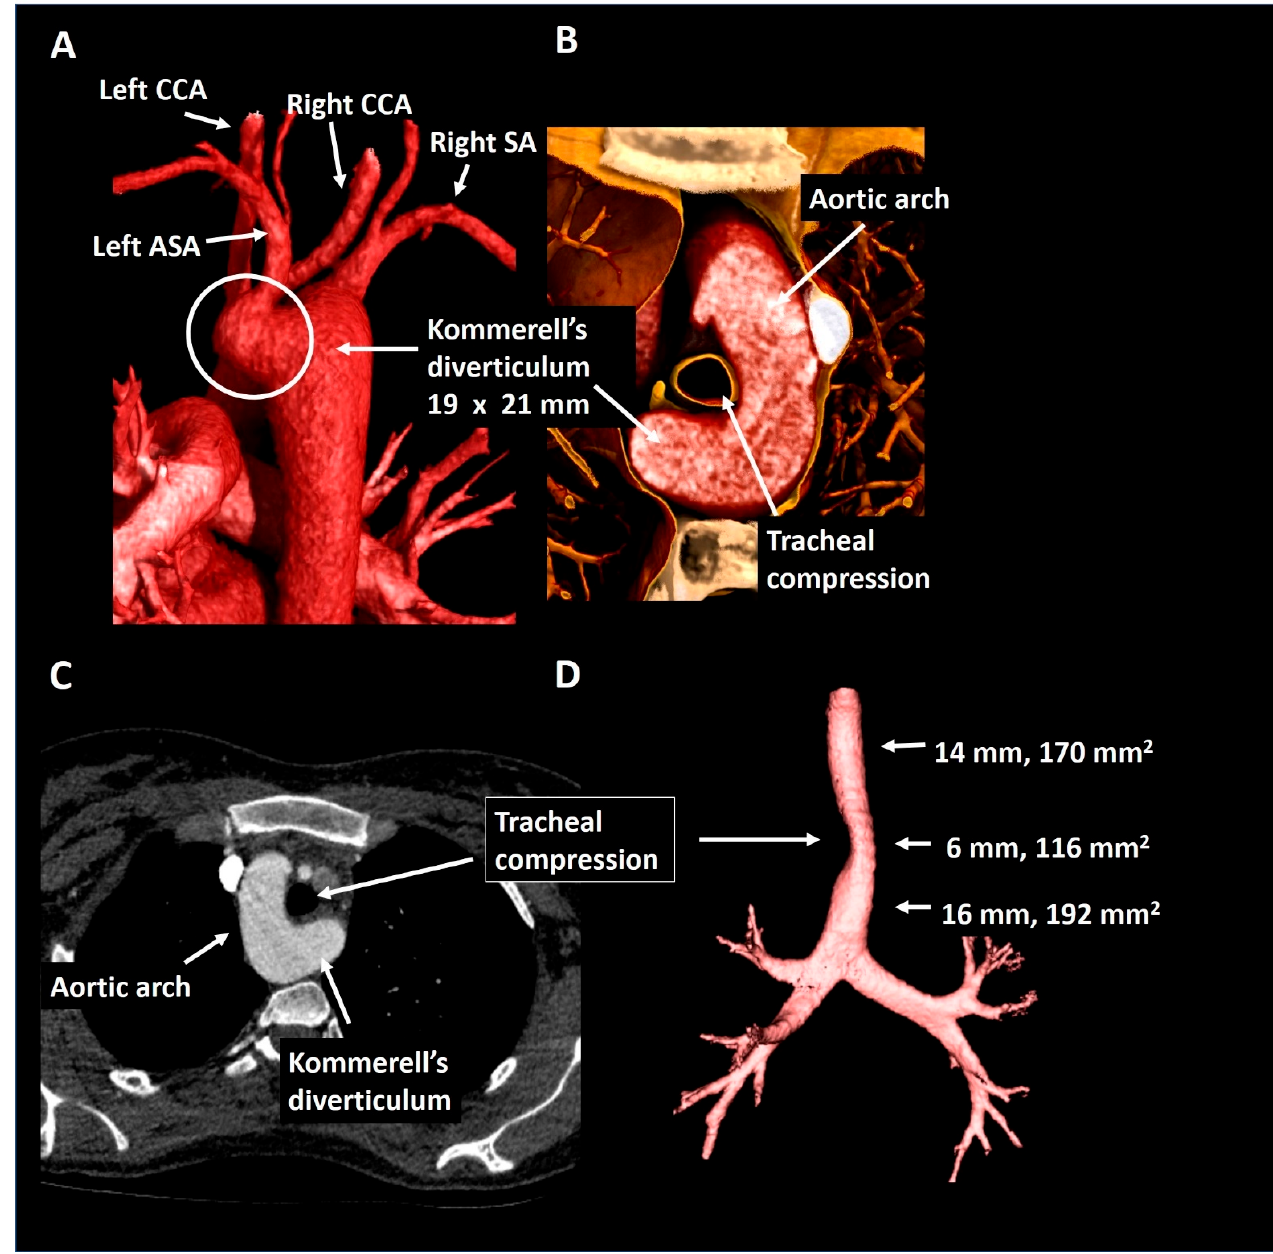
Figure 9. Patient 7. Panel ( A ) shows a posterior view of the descending thoracic aorta, right-sided aortic arch and Kommerell’s diverticulum as offset for an aberrant left subclavian artery. In panel ( B ) the short axis configuration is depicted showing mild tracheal compression. Panel ( C ) shows the axial reconstruction and panel ( D ) provides the trachea in isolation. ASA, aberrant subclavian artery; CCA, common carotid artery; SA, subclavian